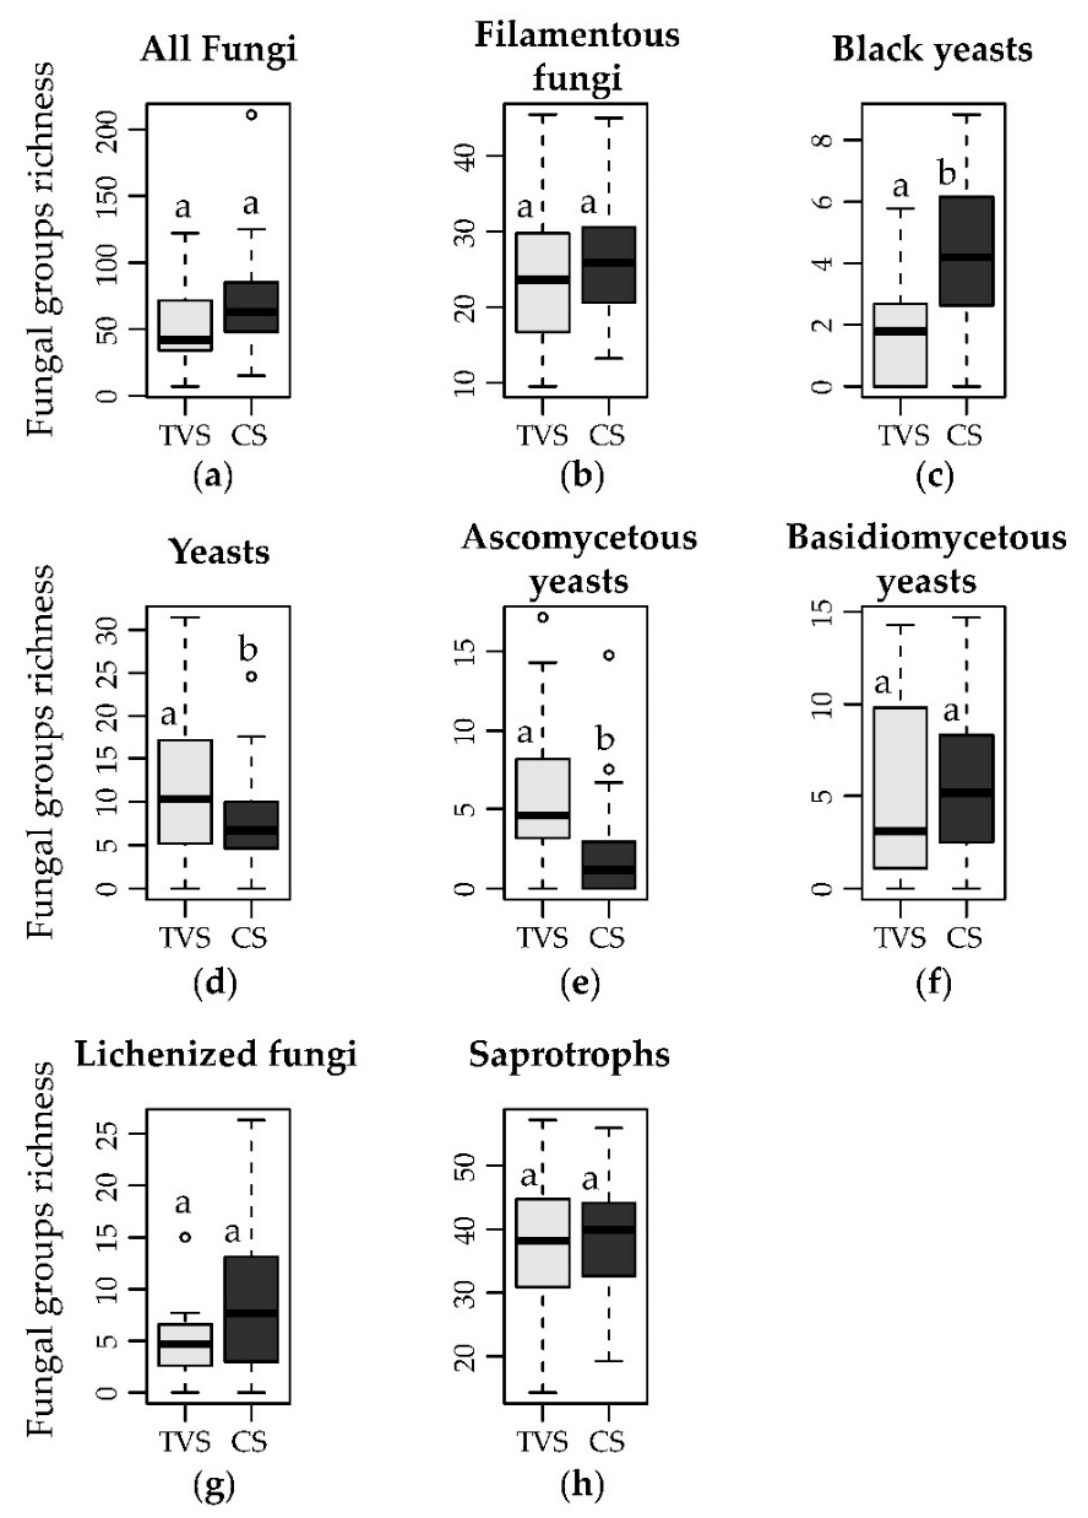
Figure 2. Richness differences between the two environments investigated. Richness of ( a ) the total fungal communities and relative richness (%) of ( b – f ) the components of the growth forms categories and ( g , h ) functional groups in the two different environments (TVS: Taylor Valley sites; CS: coastal sites) are reported.